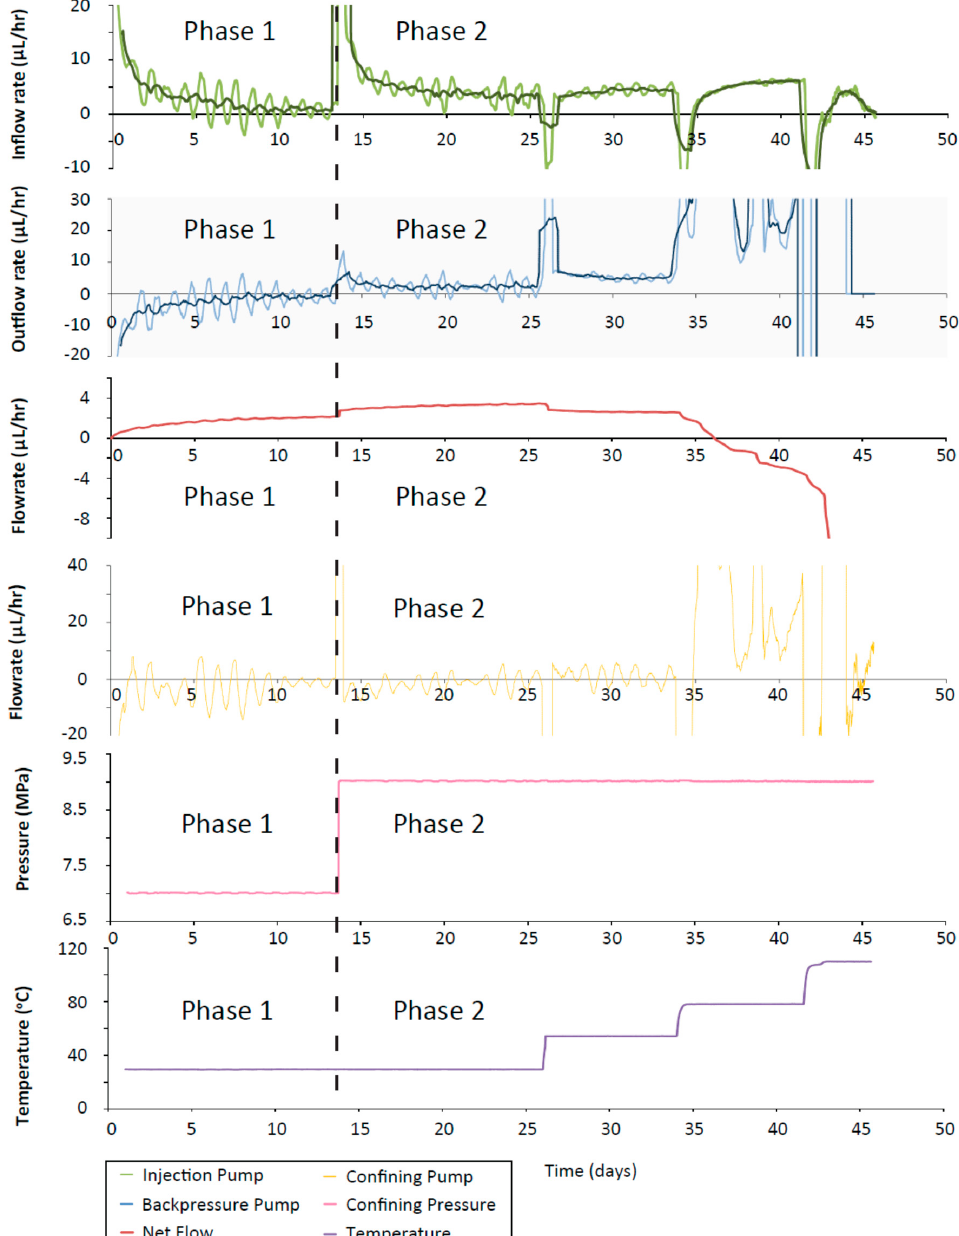
Figure 9. ISO-1 inflow (green line), outflow (blue line) and confining pump (orange line) flow-rates. Data are subsampled once every 30 min and a 20 point moving average filter (representing a 10 h window) has been applied. Bold lines (green and blue) show an additional 50 point moving average filter (every 25 h). Net flow (red line) shows a decrease with each temperature increase. The confining pressure (pink line) and vessel temperature (purple line) are shown.